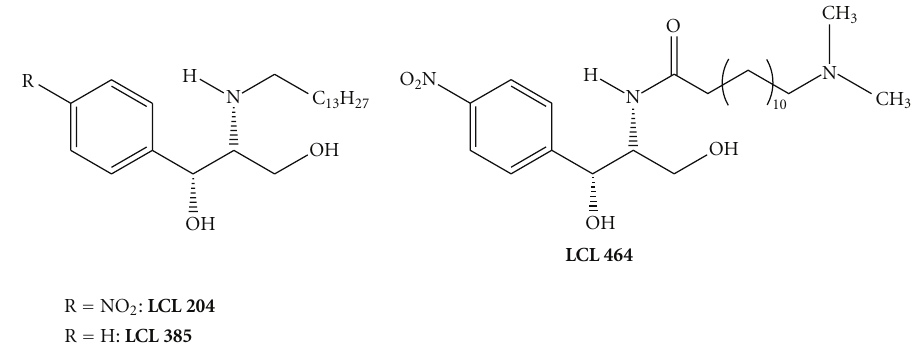
Figure 2: Some of the basic analogues of D-MAPP and B-13 developed by Gatt et al. (LCL 204, LCL 385) and by Bielawska et al. (LCL 464).